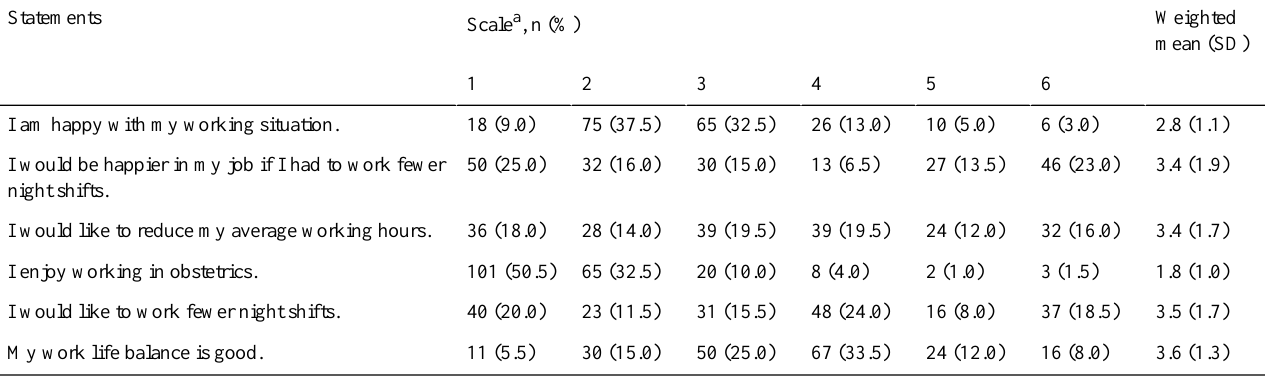
Table 2. Attitude toward their current job situation